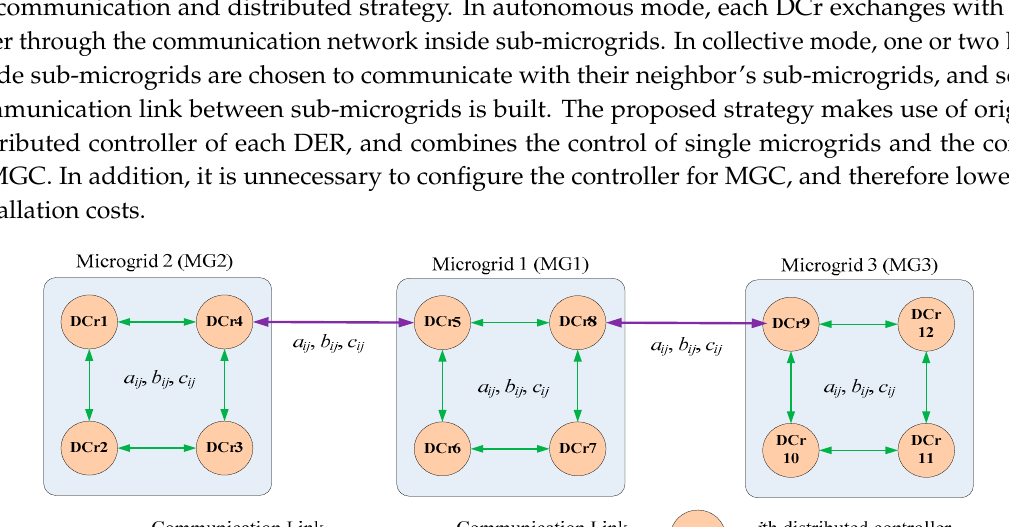
k U Figure 2. Block diagram of the overall control architecture for a single distributed energy resource (DER). In a distributed sparse communication network, each DCr only interacts with information from adjacent DCrs, so high reliability can be achieved, as a dominant DCr is not necessary. Taking DER i for an example, DCr i sends its relevant information ( i Q ,